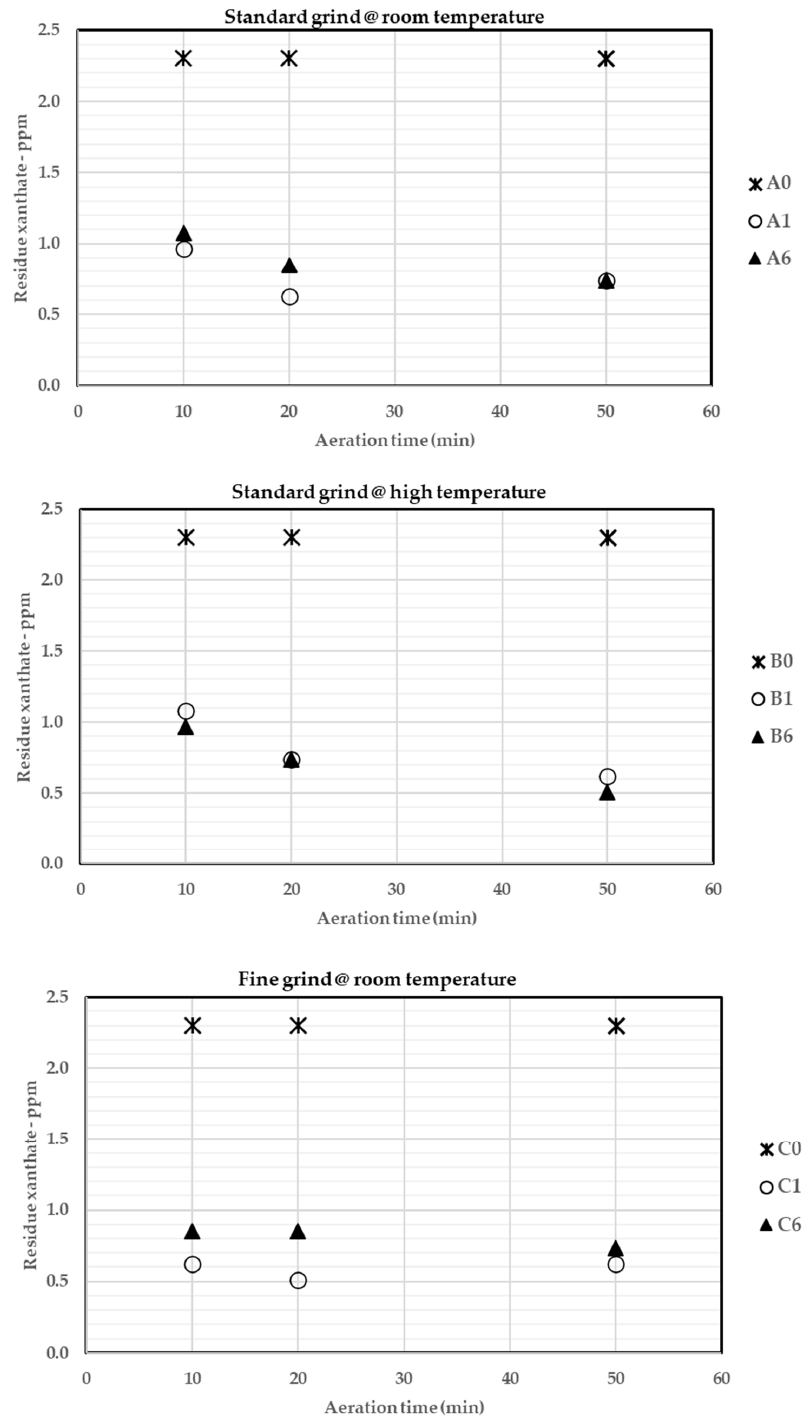
Figure 9. Residue xanthate vs. aeration time using 1 and 6 dissolution loops in water under normal temperature ( A ), high temperature ( B ), and fine grind ( C ).